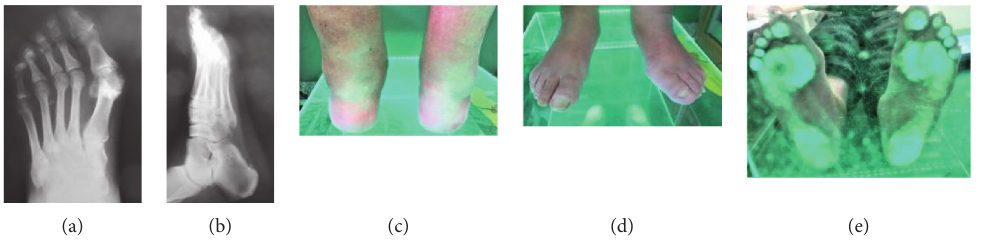
Figure 5: (a–f) Results of imaging tests (X-ray) and podoscopic tests: patient no. 6. (a) Dorsal-plantar foot X-ray: degeneration of the I head of metatarsal bones, phalangeal valgity, and overload lesions in metatarsophalangeal joints. (b) Lateral foot X-ray: enthesopathy of the plantar fascia and inflammation in the metatarsophalangeal joints. (c) Posterior photo: ankle joint and hindfoot evaluation. (d) Anterior picture of the feet: assessment of toe positioning and deformation. (e) Plantar photo on the podoscope: assessment of plantar part of the foot and height measurement of the longitudinal